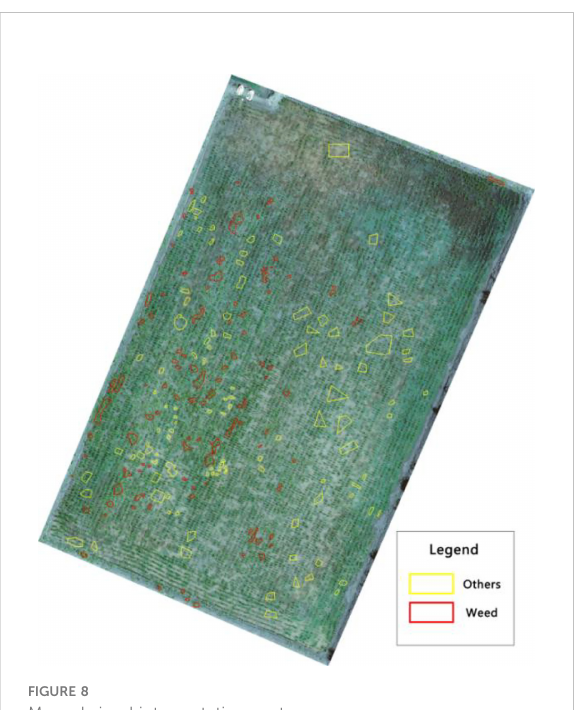
FIGURE 8 Manual visual interpretation vector map.